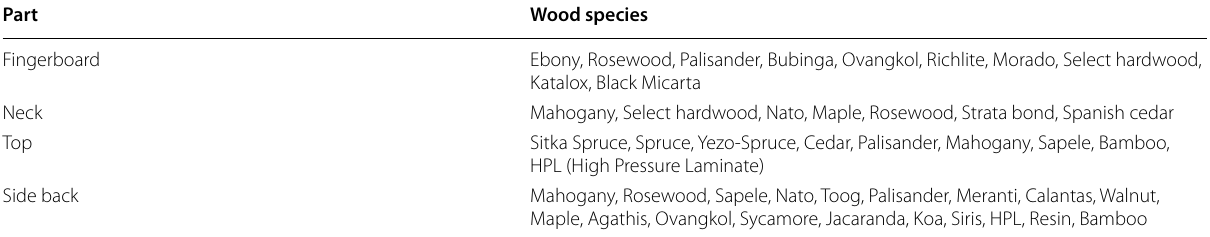
Table 1 Species of wood used in acoustic guitar parts (Martin/Yamaha) Part Wood species